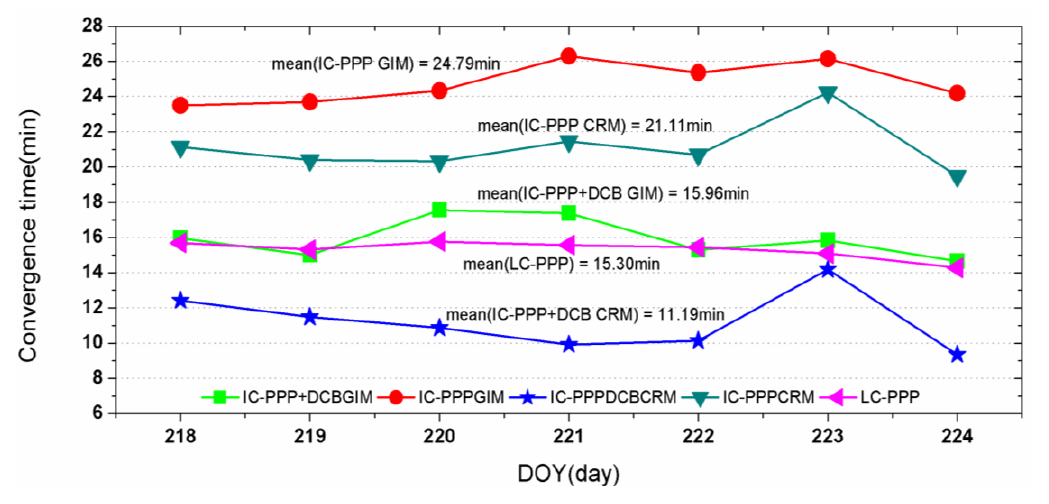
Figure 12. Mean convergence time into 10 cm in both North and East components of five PPP solutions using CMONOC data